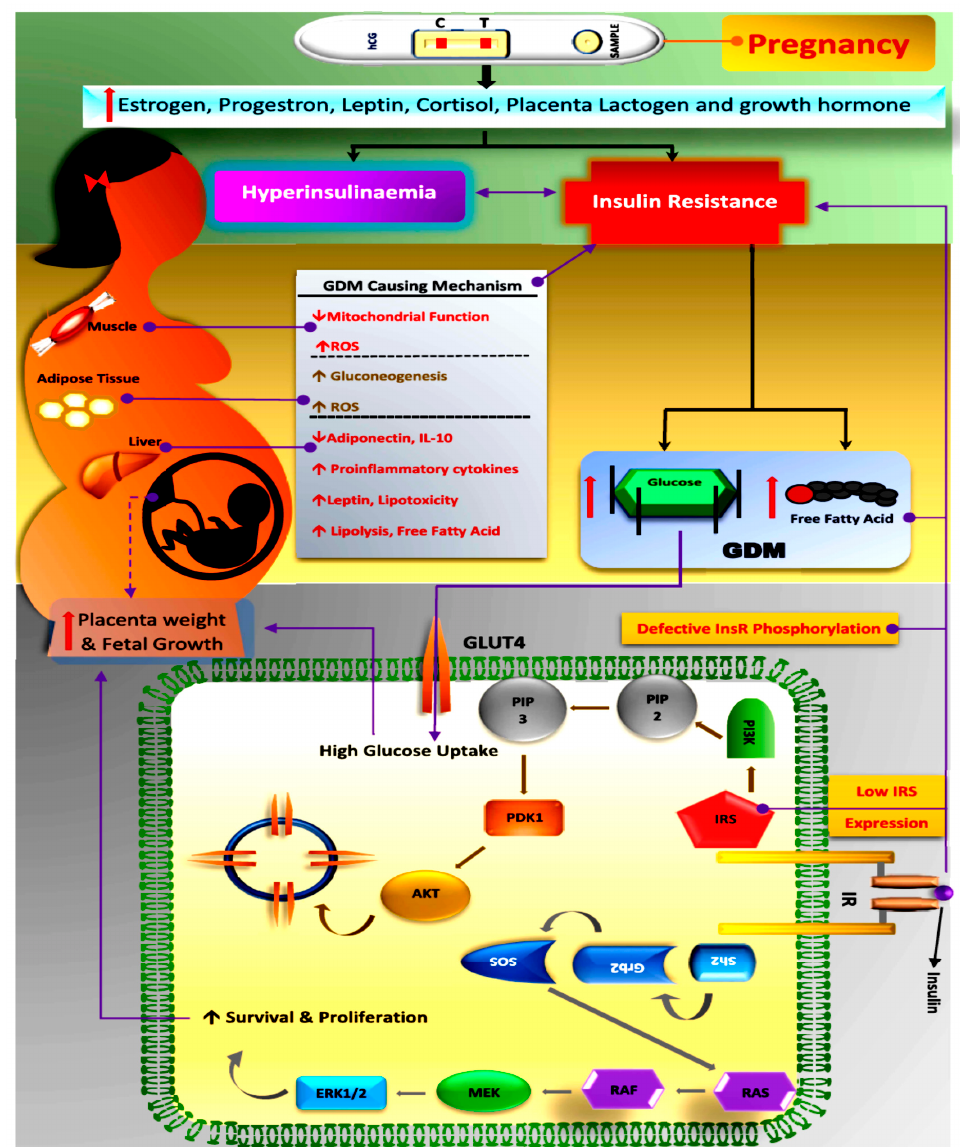
Figure 2. Schematic diagram showing the pathophysiology in the GDM-affected female, highlighting factors inducing hyperinsulinemia and insulin resistance. Glucose uptake via insulin signalling takes place through the auto-phosphorylation of the insulin receptor, thereby activating and recruiting GLUT molecules to open cell channels/gates for glucose uptake in skeletal muscles. Downstream effectors, such as IRS-1 and phosphatidyl inositol 3-kinase (PI3K), are major players that are activated, resulting in GLUT recruitment, which opens the membrane channels for glucose uptake intracellularly. GDM-affected pregnant females in late gestation exhibit regressed IRS1 expression, which minimizes tyrosine phosphorylation in a β subunit of the insulin receptor, which finally results in increased glucose tolerance or insulin resistance. The most visible complication of GDM is increased placental weight and an oversized foetus, which is due to high glucose uptake. (GDM: Gestational Diabetes Mellitus; ROS: Reactive Oxygen Species; IL: Interleukin; GLUT: Glucose Transporter Protein; PIP: Phosphatidylinositol phosphate; PI3K: Phosphoinositide 3-kinases; PDK1: Pyruvate Dehydrogenase Kinase; AKT: Protein Kinase B, also known as AKT; SOS: Son of Sevenless; Grb2: Growth Factor Receptor-Bound Protein 2; Sh2: Src Homology 2; RAS: Rat Sarcoma Virus; RAF: Rapidly Accelerated Fibrosarcoma; MEK: Mitogen-Activated Protein Kinases; ERK1/2: Extracellular Signal-Regulated Kinase 1/2; InsR: Insulin Receptor; IRS: Insulin Receptor